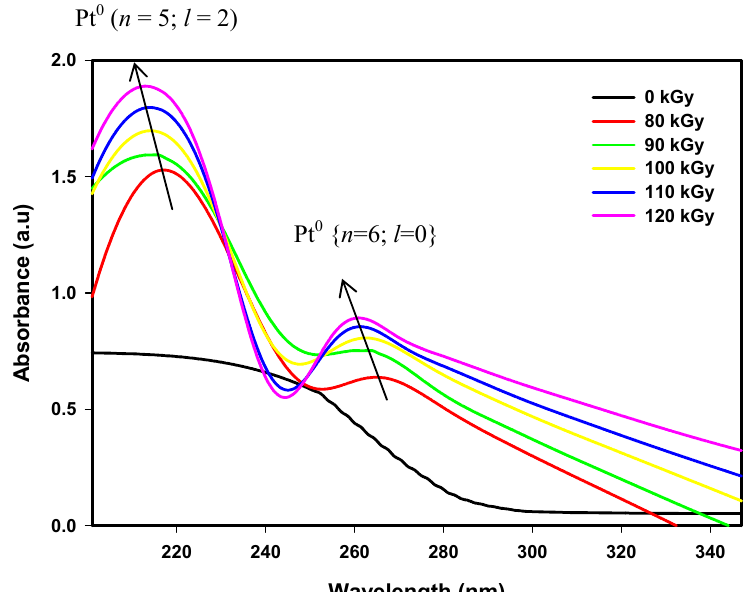
Figure 5. UV–visible absorption spectra of colloidal Pt nanoparticles synthesized by the gamma radiolytic method showing the evolution of two steady absorption peaks of 216 and 264 nm, in which the absorbance increased with increasing dose owing to the increased number of Pt nanoparticles with increasing dose. The absorption peaks blue shifted with increasing dose owing to a decrease in particle